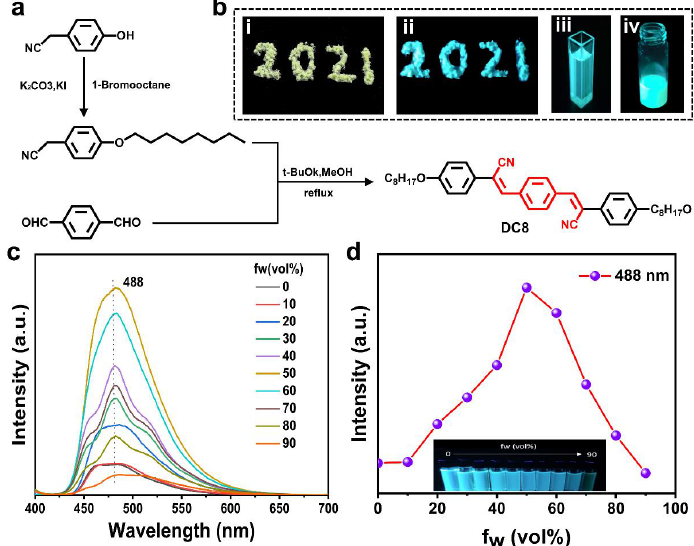
Figure 2. ( a ) Synthetic route of fluorescent molecule DC8. ( b ) Photographs of DC8 crystal under white light ( i ), upon UV irradiation ( ii ), and in THF solution (c = 10 −4 M) upon UV irradiation ( iii ). A photograph of fluorescent LC mixture (0.25 wt% DC8 in LC host SLC-1717) upon UV irradiation ( iv ). ( c ) Photoluminescence (PL) spectra of DC8 in THF and THF/water mixtures (c = 10 −4 M). The excitation wavelength is 388 nm. ( d ) A plot of the emission intensity at 480 nm versus water fractions ( f w ) for DC8 in THF and THF/water mixtures.